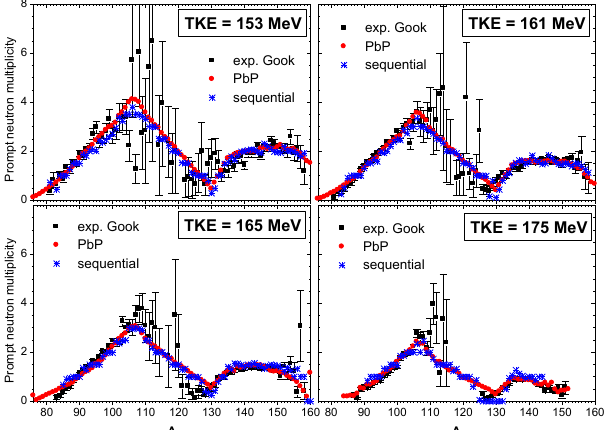
Fig.2. Comparison of the ν (A,TKE) results of PbP (red circles) and sequential emission (blue stars) with the recent data of Göök et al. (black squares) in the representation as ν (A) at a given TKE value (which is indicated in each frame).